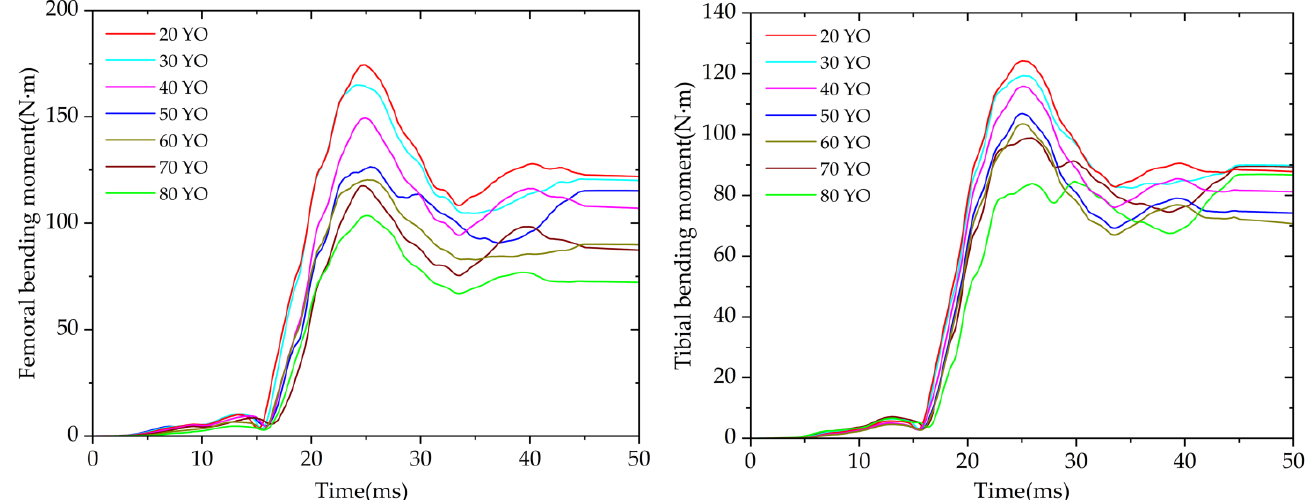
Figure A2. Bending moment of femur and tibia of pedestrians of seven ages at 30 km/h.